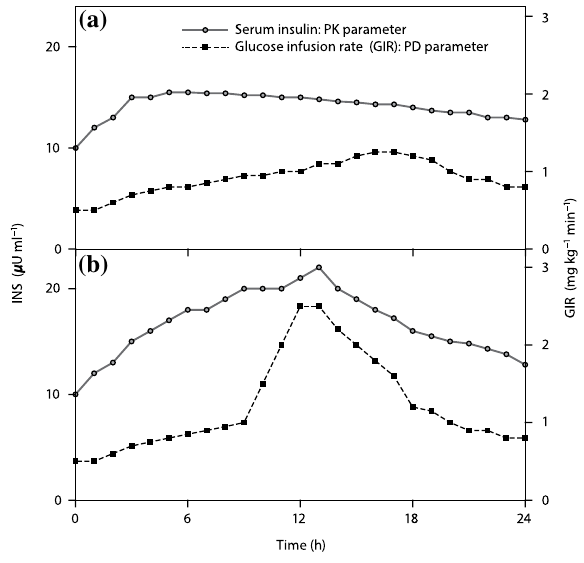
Figure 2: PK/PD profile of a longer acting basal analogue insulin where Figure 2. PK/PD profile of a longer-acting basal analogue insulin where (A) indicate the ideal PK/PD profile and (B) indicate a non-ideal PK/ (A) indicates the ideal PK/PD profile and (B) indicates a non-ideal PK/ PD profile. The PK/PD profile of a longer acting basal analogue insulin PD profile. The PK/PD profile of a longer-acting basal analogue insulin obtained from a euglycemic glucose clamp study should ideally have obtained from a euglycemic glucose clamp study should ideally have a flat, peakless serum insulin concentration curve suggesting reduced a flat, peakless serum insulin concentration curve suggesting reduced risk of hypoglycaemia. 6 A minimum duration of action of 24 h should be risk of hypoglycaemia. 6 A minimum duration of action of 24 h should be observed in order to allow for once daily administration. 2 It should be observed in order to allow for once-daily administration. 2 It should be considered that the full duration of action of the study insulin may not be observed during the period of the glucose clamp